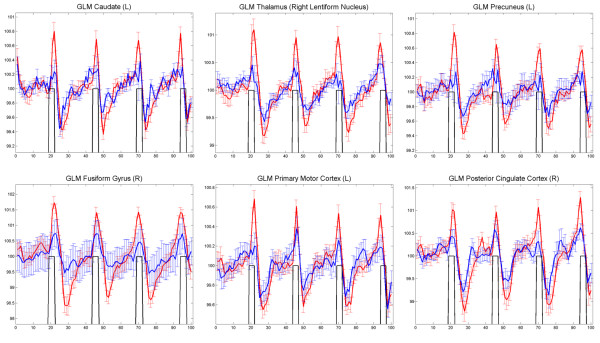
The average BOLD signal extracted from clusters that demonstrated significantly decreased CVR. The red lines represent the signal from the SL group and the blue lines represent the signal from the HA group; the black lines represent the task reference; the periods when the black lines are absent are resting periods without performing the cued maximum inspiration task. Error bars are plotted on the average signal of each group at each time point, representing cross-subject variance measured in SD.